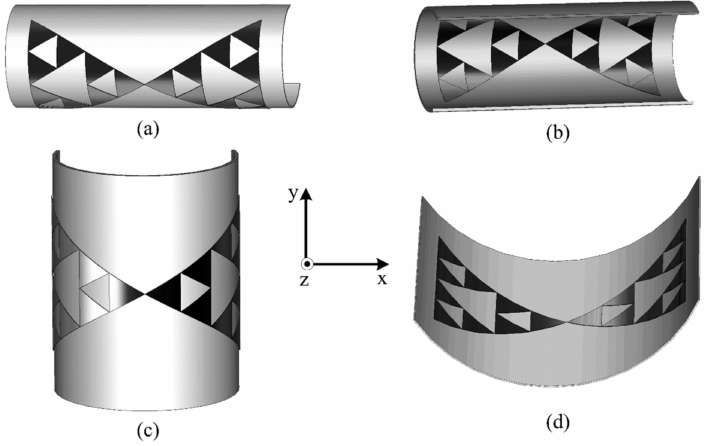
Figure 5. Bent conditions: ( a ) Concave-x, ( b ) convex-x, ( c ) concave-y and ( d ) convex-y.